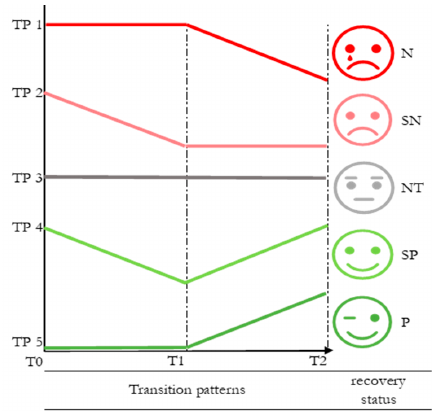
Figure 4. Conceptual framework of the recovery process in a 3-time frame; 1. Negative recovery (N); 2. Slightly negative recovery (SN); 3. Neutral recovery (NT); 4. Slightly positive recovery (SP); 5. Positive recovery (P).